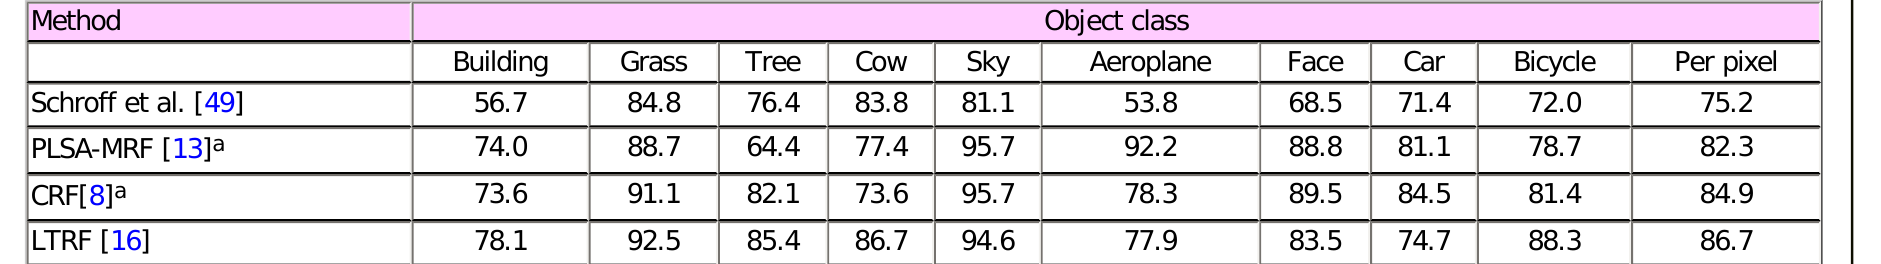
Table 4 Pixel level labeling accuracies (%) for various algorithms on